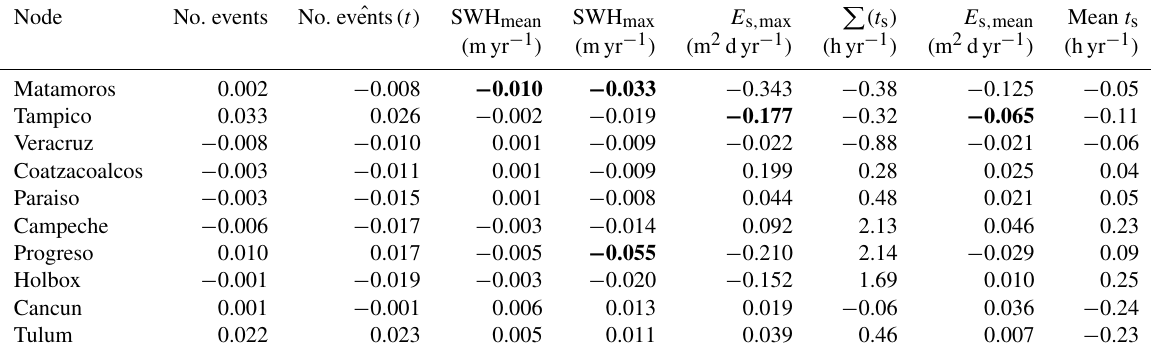
Table 2. Trends found in the number of Norte events, estimated number of Norte events, SWH mean and SWH max , E s , mean , total t s , E s , max and mean t s per season. Bold font indicates that the presence of a trend is confirmed by the Mann–Kendall test at the 90% confidence level. Node No. events No. ˆ events (t) SWH mean P (t s )